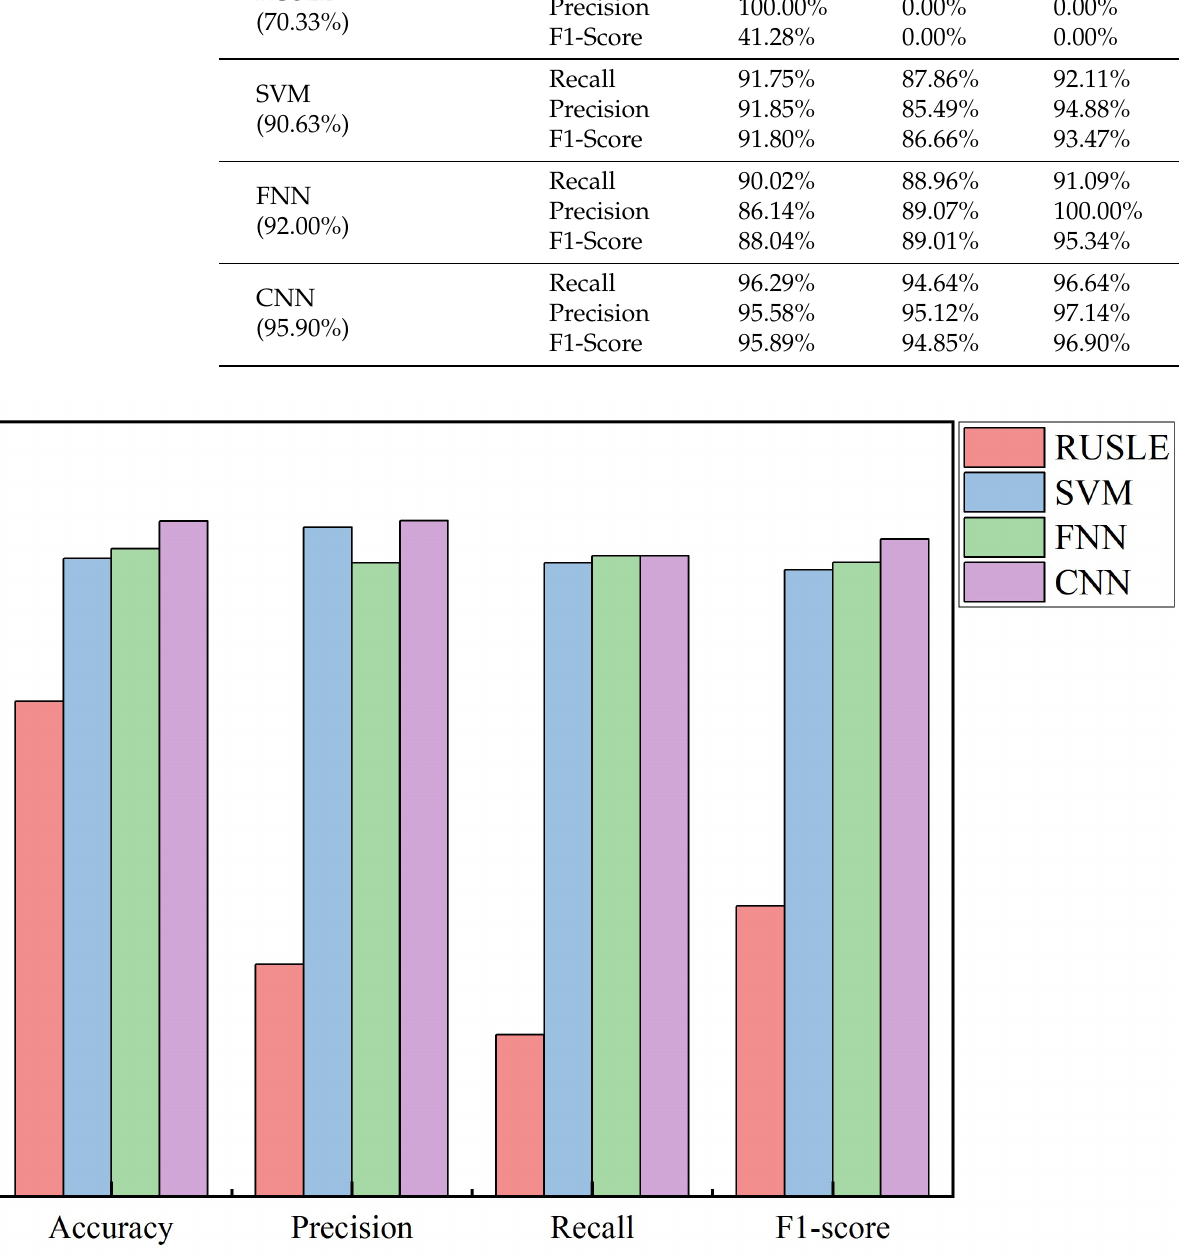
Figure 7. The classification evaluation index results of the three models. By comparing the output results of the RUSLE, SVM, FNN and CNN models, this study selects CNN as the model for predicting soil erosion in ecorestoration and studies the spatial distribution rules of soil erosion in the studied area by the CNN model, as shown in Figure